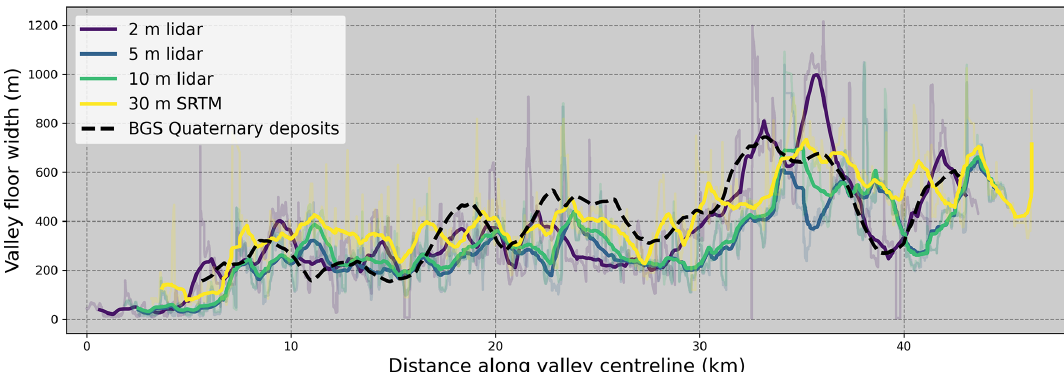
Figure 8. Valley floor width along the valley centreline for the Weardale catchment, tested on DEMs of varying resolution. The light grey lines show the raw data, and the darker coloured lines show the rolling average of width over a 500m window. We show the results from lidar-derived datasets at 2m (dark blue), 5m (blue), and 10m (green), along with the SRTM 30m dataset (yellow). The dashed black line shows the results from the valleys identified using the BGS Quaternary deposits maps (scale of 1 : 50000, corresponding to a DEM resolution of ≈